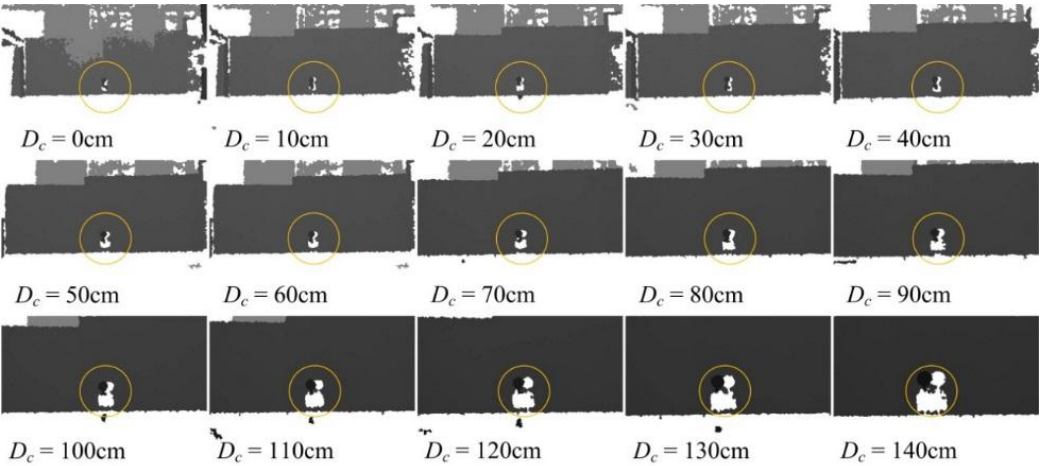
Figure 16. Depth images at different controlled displacements in the dynamic cooperative distance detection.